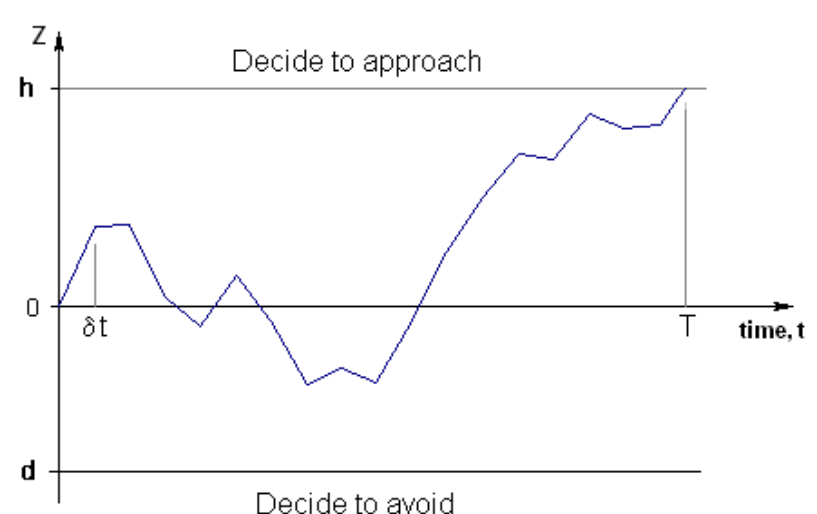
Figure 4. The drift diffusion